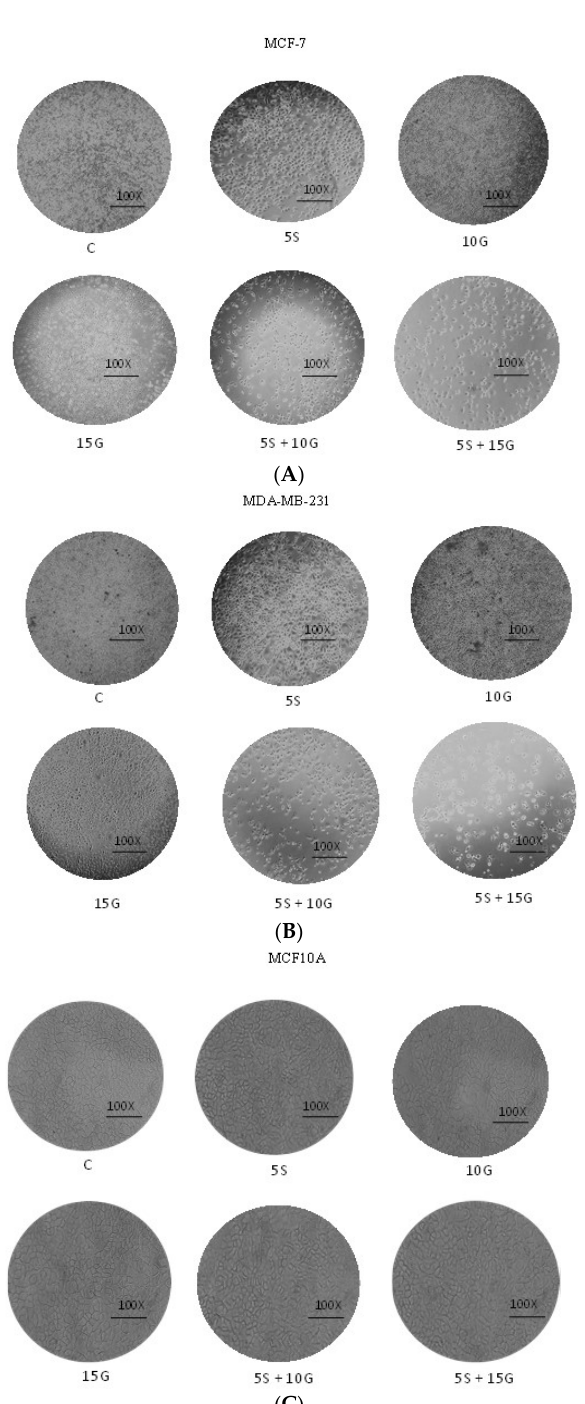
Figure 3. Cell density. Combinatorial GEN and SFN promote a decrease in cell density of breast cancer cells. ( A ) MCF-7 breast cancer cells were treated with 5.0 µM SFN and 10.0 µM GEN or 15.0 µM GEN singly and in combination for three days. Photographs were taken on the fifth day of culture; ( B ) MDA-MB-231 breast cancer cells were treated with 5.0 µM SFN and 10.0 µM GEN or 15.0 µM GEN singly and in combination for three days. Photographs were taken on the fifth day of culture; ( C ) MCF10A non-cancerous control cells were treated with 5.0 µ M SFN and 10.0 µ M GEN or 15.0 µ M GEN singly and in combination for three days. Photographs were taken on the fifth day of culture. Dimethyl sulfoxide (DMSO) treatment served as control. Photos are representative of three